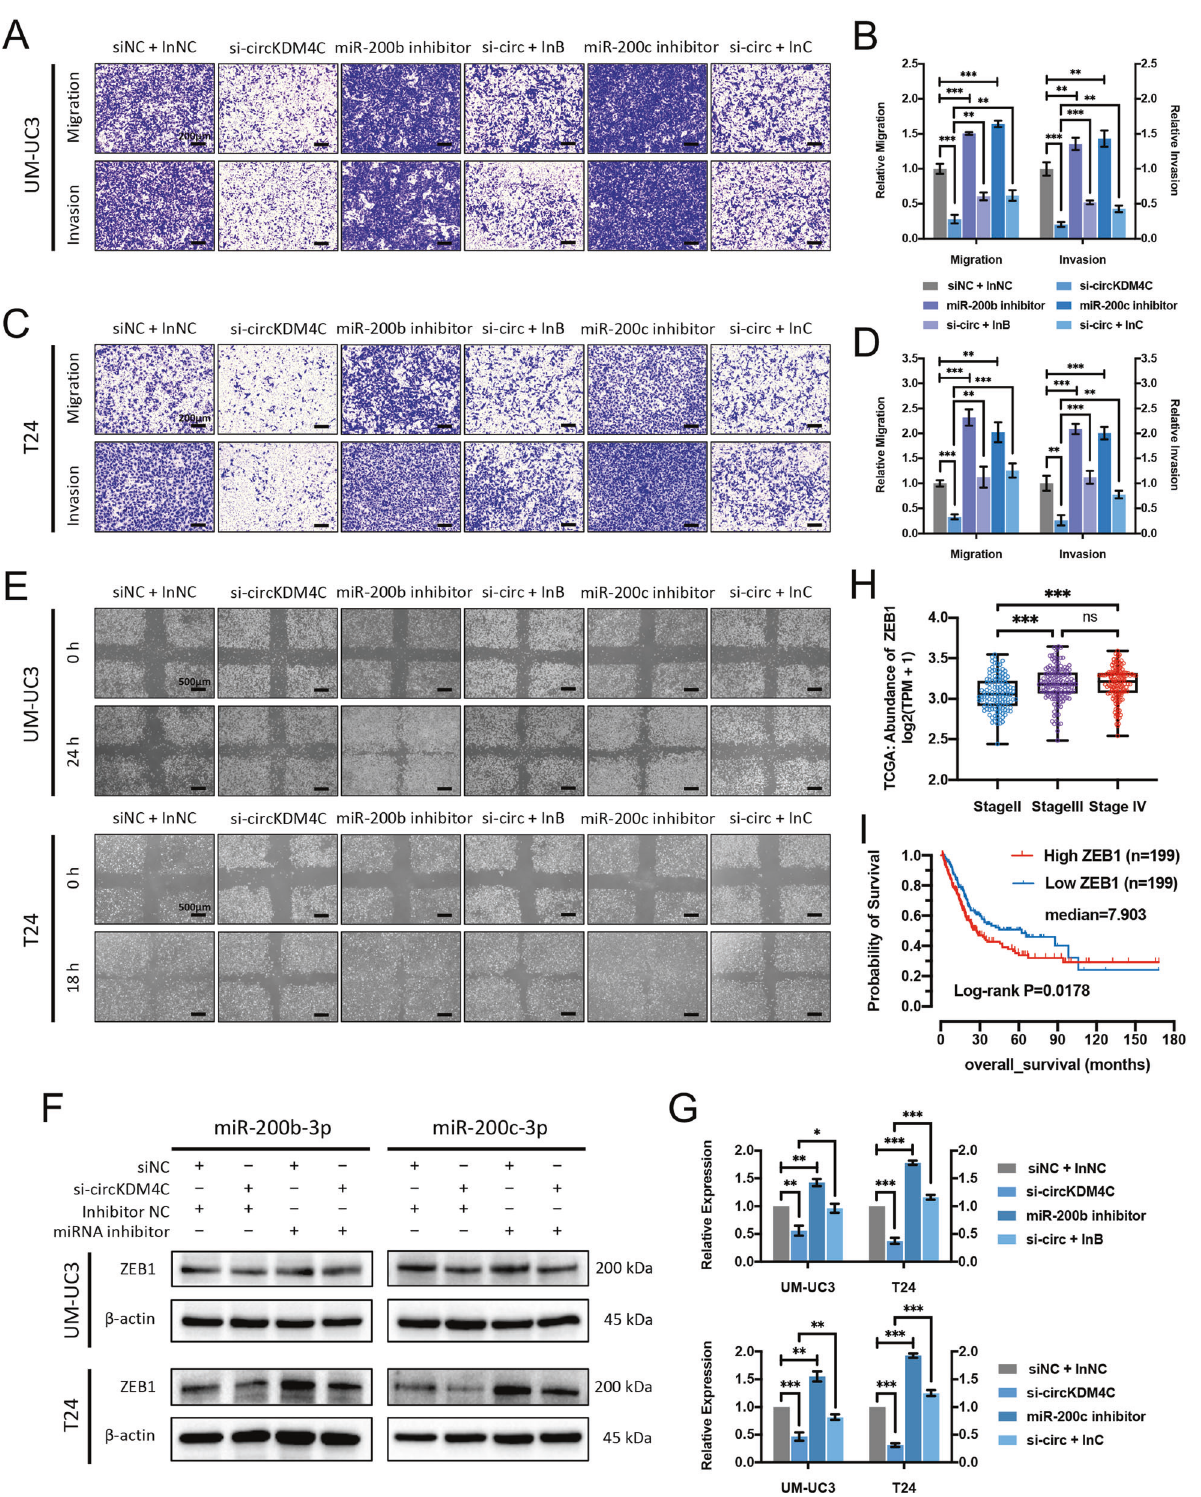
Fig. 5 circKDM4C sponges miR-200b-3p and miR-200c-3p to enhance ZEB1 expression and promote BCa cell migration and invasion. A – D Transwell migration and Matrigel invasion assays for UM-UC3 ( A, B ) and T24 ( C, D ) cells after circKDM4C knockdown alone or cotransfected with miR-200b-3p or miR-200c-3p inhibitors. Scale bar = 200 μ m. E Wound-healing assays of UM-UC3 and T24 cells. Scale bar = 500 μ m. F Western blotting assays showed that miR-200b-3p/miR-200c-3p inhibitors partly reversed the decrease of ZEB1 expression induced by circKDM4C knockdown in BCa cells. G Quanti fi cation of ZEB1 levels. H Expression levels of ZEB1 in different pathologic-stage BCa from the TCGA database. I Kaplan – Meier survival analysis indicated poorer survival probability in BCa patients with higher ZEB1 expression. InNC: inhibitor NC; InB/InC: miR-200b-3p/miR-200c-3p inhibitor. Data are expressed as the means ± SD for n = 3. ns, no signi fi cance; ** P < 0.01; *** P < 0.001.